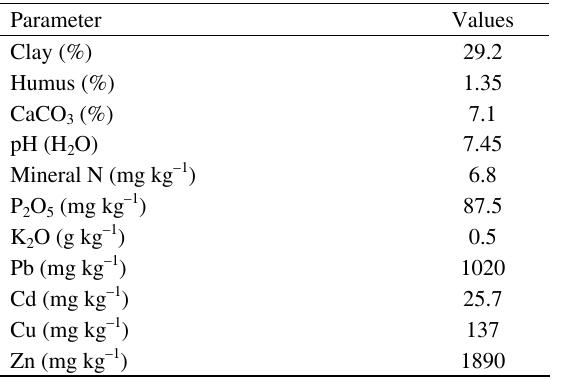
Table 1 . Physical and chemical characteristics of the contami- nated soil (the results are the mean of three